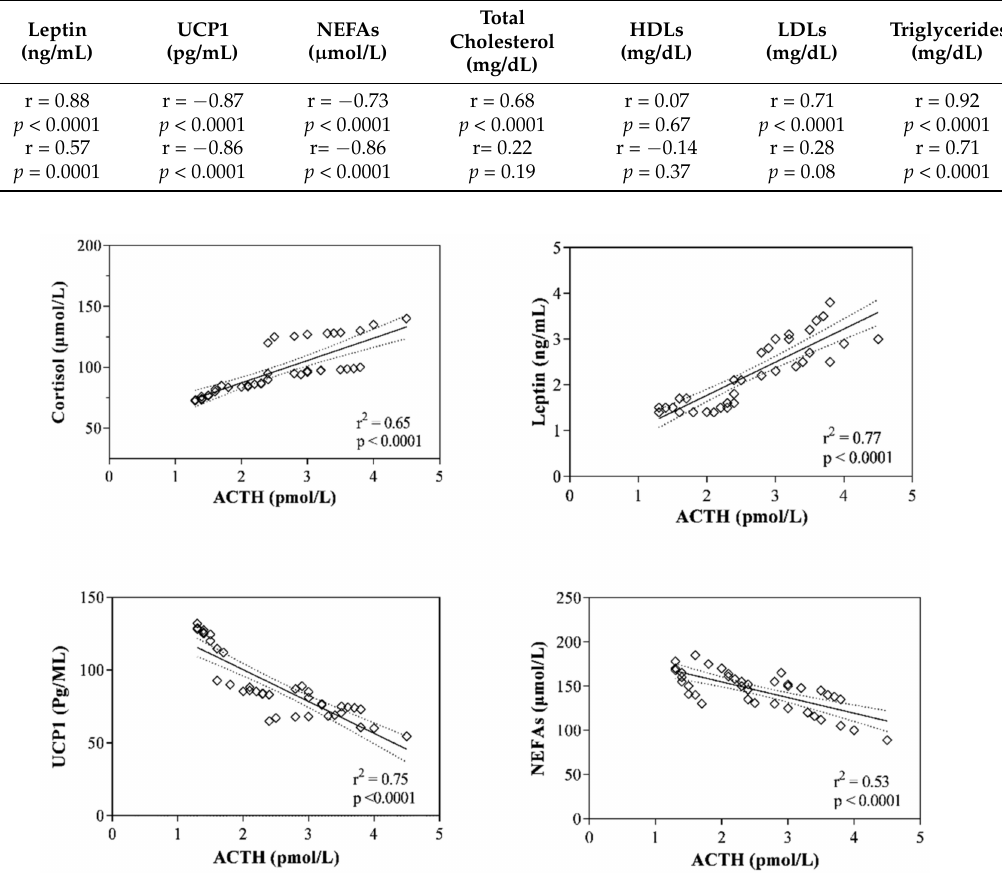
Table 1. Coefficients of correlation among the values of plasma ACTH and/or serum cortisol and the serum concentration of leptin, mitochondrial uncoupling protein 1 (UCP1), non-esterified fatty acids (NEFAs), total cholesterol, high-density lipoproteins (HDLs), low-density lipoproteins (LDLs) and triglycerides calculated for mares of Group A during the peripartum period. P -values < 0.05 were considered statistically significant.